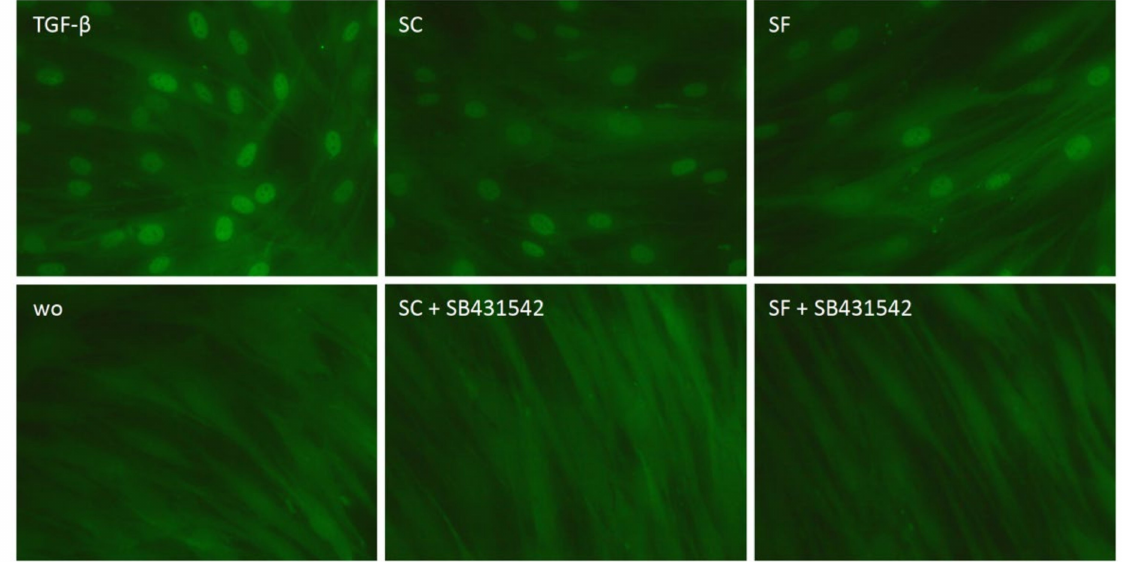
Figure 5. Nuclear translocation of Smad2/3 in response to the allograft supernatants. Gingival fibroblasts were exposed to aqueous supernatants of OraGRAFT ® Demineralized Cortical Particulate (SC) and OraGRAFT ® Prime (SF) with and without the TGF- β receptor type I kinase-inhibitor SB431542. Recombinant TGF- β 1 served as a positive control. Without (wo) is the serum-free medium alone. The positive signals induced by SC and SF are indicated by the nuclear staining that is blocked by the